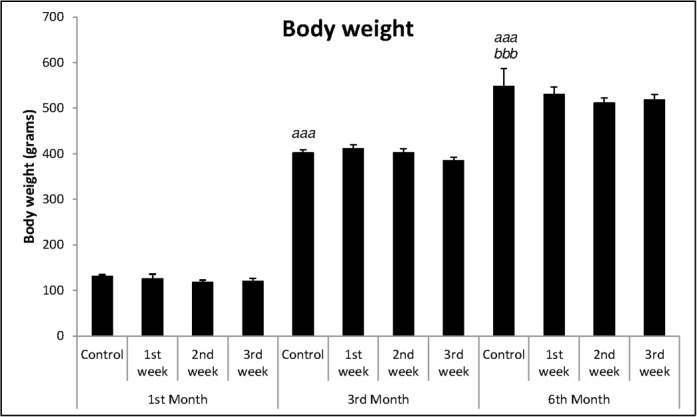
Mean + SEM of body weight in grams.One-way ANOVA followed by Duncan’s test, where: aaap<0.001 in relation to control group of 1st month and bbbp<0.001 in relation to control group of 3rd month.